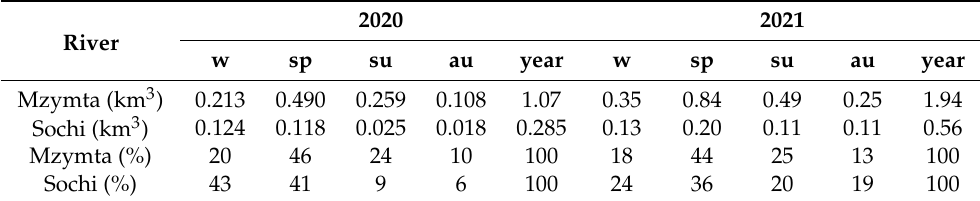
Table 1. Seasonal and annual freshwater discharges (km 3 ) for the Mzymta and Sochi rivers Figure 1. Study area, bathymetry, and locations of the rivers addressed in this study. The black box at the inset shows the location of the study area in the northeastern part of the Black Sea.